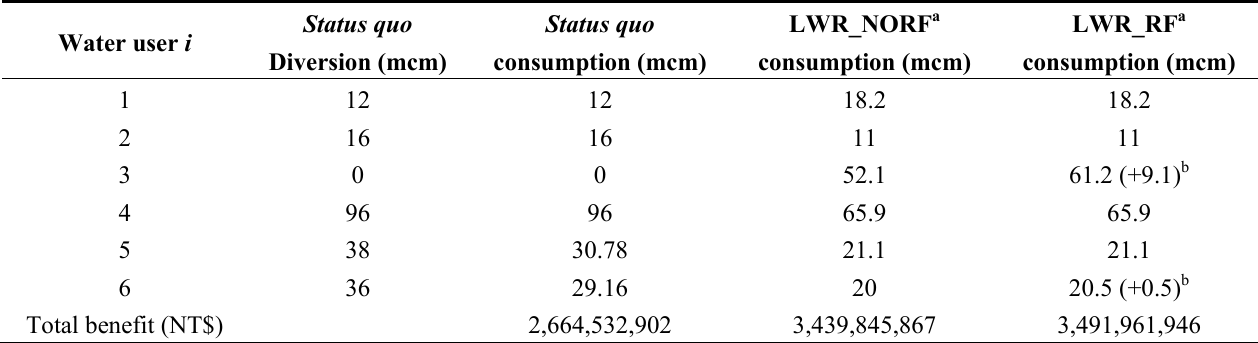
Table 2. Individual water consumption and total